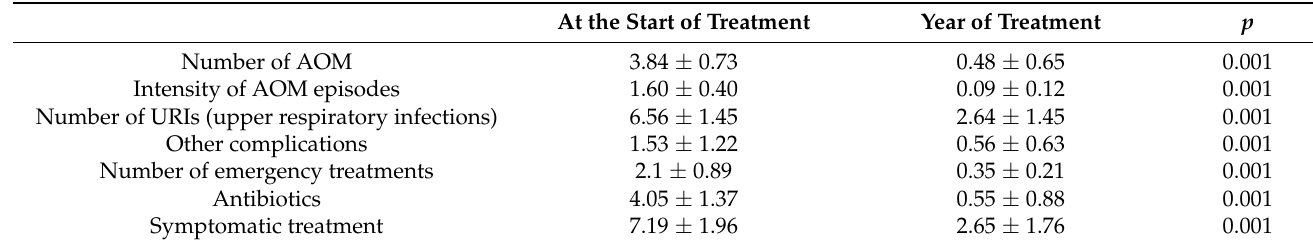
Table 5. Evolution during the previous year and during the year of treatment. At the Start of